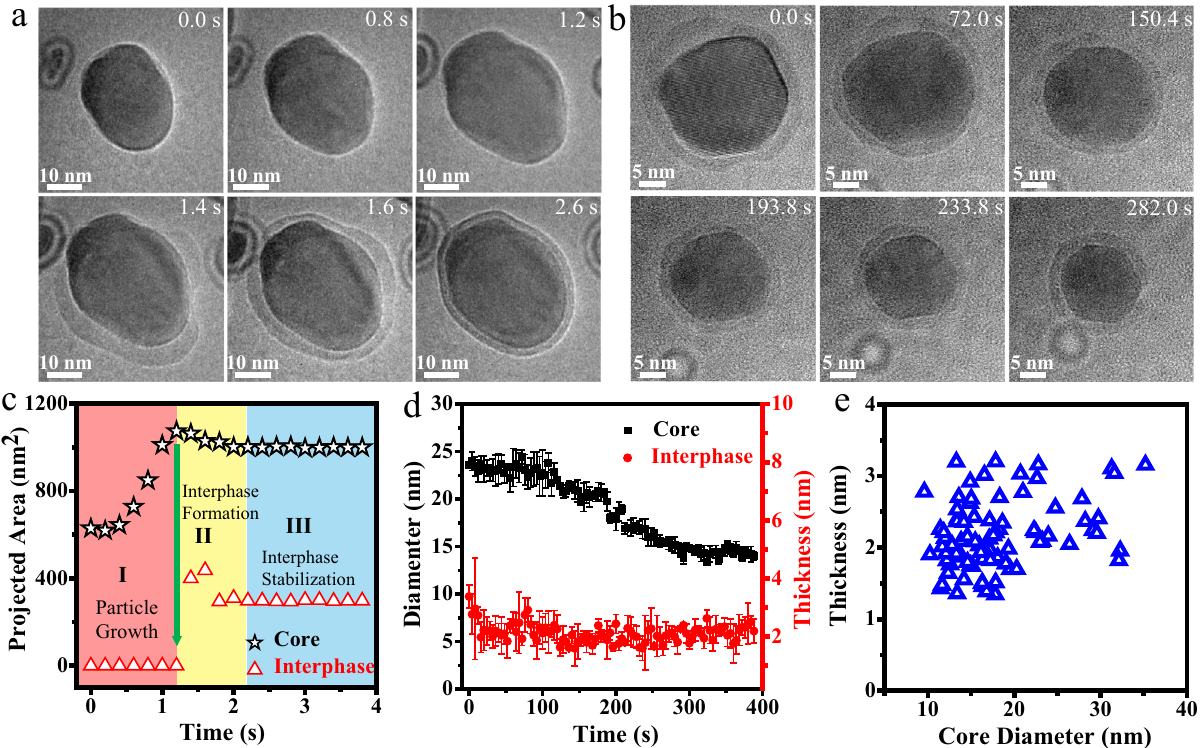
Fig. 2 Formation and stabilization of quasi-liquid phase during In nanocrystal growth and dissolution. a Sequential TEM images showing the growth of the In nanocrystal and formation of the quasi-liquid phase. Three distinct stages can be identi fi ed, namely the growth of the In nanocrystal (stage I), the appearance of the interphase (stage II) and the stabilization process of the interphase (stage III). b Sequential images showing no obvious change in the thickness of the quasi-liquid phase during the etching of the In core. c The projected area of the In core and interphase as a function of time, corresponding to a . The projected area of the core decreased at the moment when the interphase appeared (yellow area). d Diameter of the In core and thickness of the interphase as a function of time, corresponding to b . The error bars represent the difference between each set of data (three sets of data are measured at different positions of the same particle) and averaged diameter/thickness. e Statistical analysis of core diameter and the quasi-liquid phase thickness distribution for more than 80 nanocrystals. Source data are provided as a Source Data fi